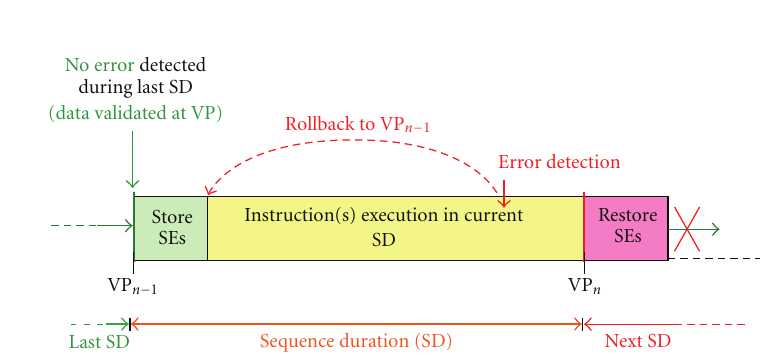
Figure 6: Overall Architecture.